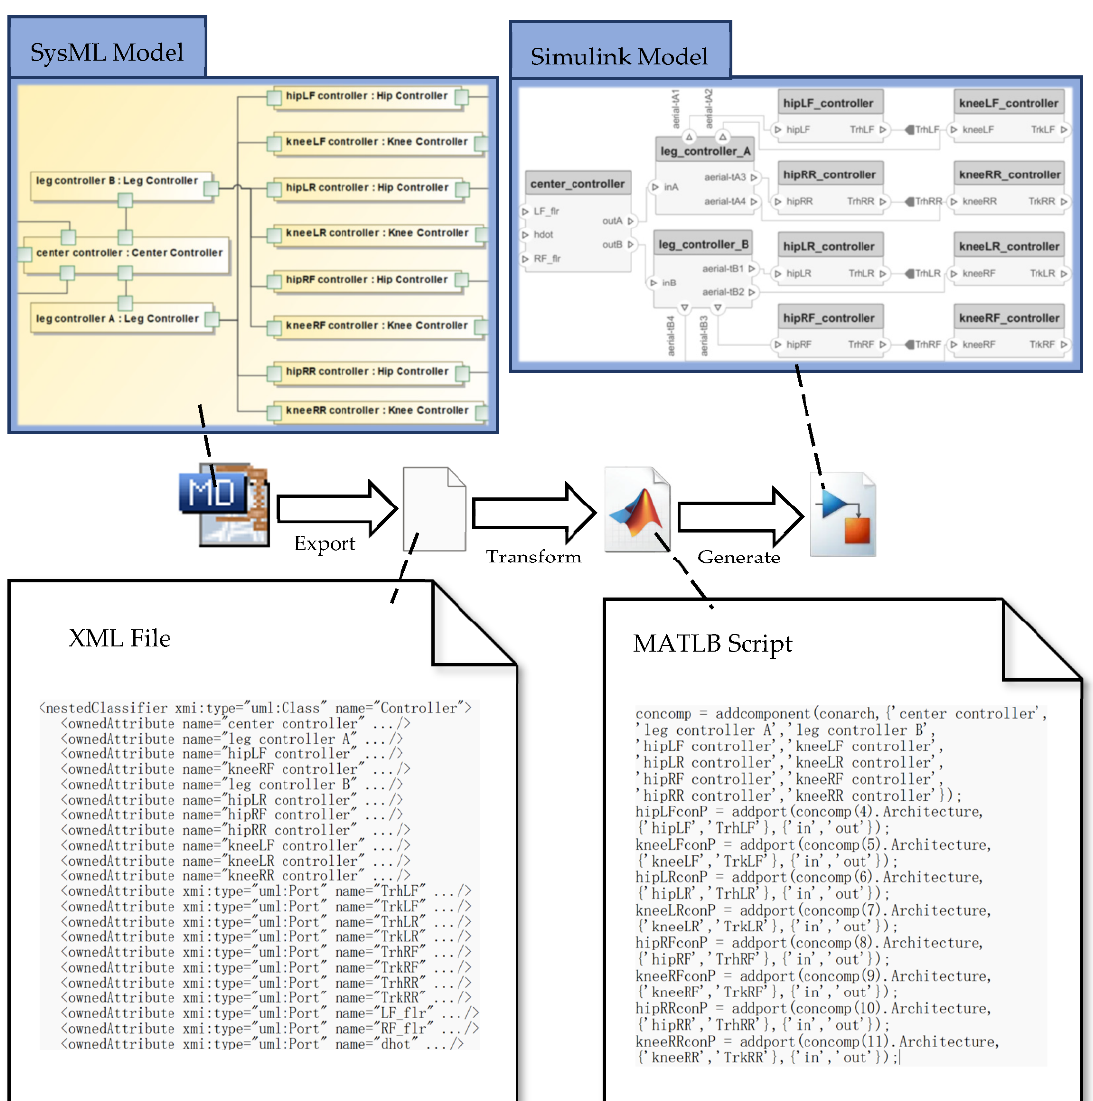
Figure 14. Transformation process for the logical architecture of the quadruped robot based on the synchronous transformation framework.